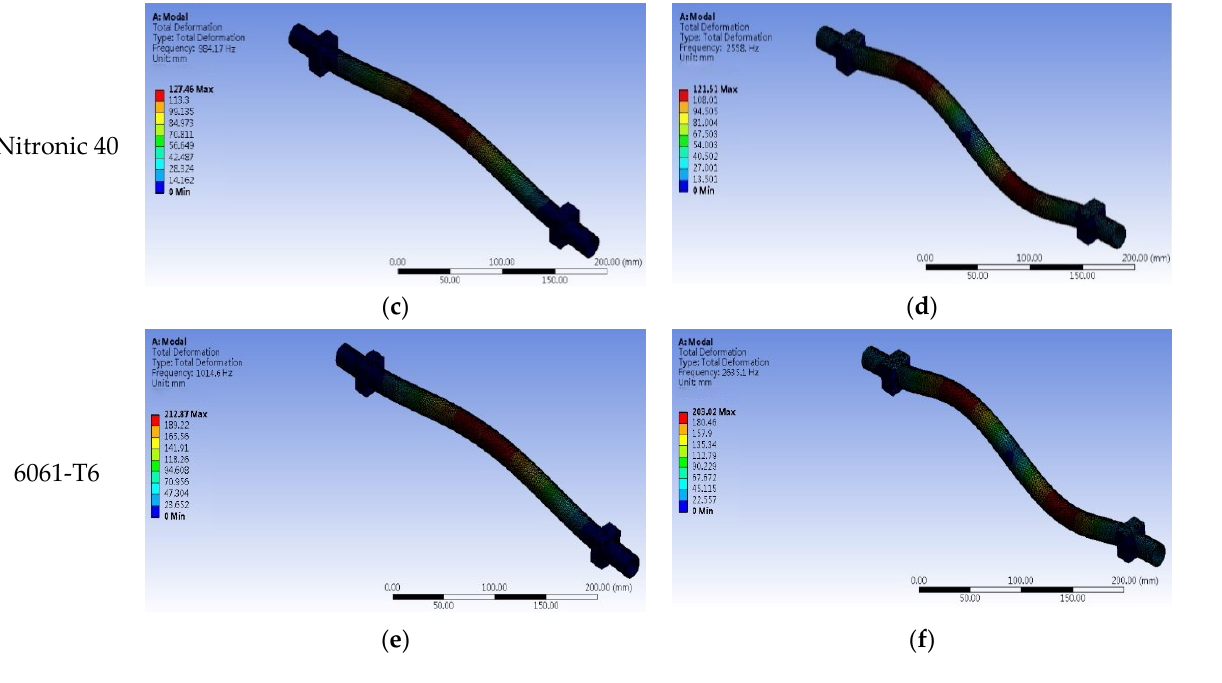
Figure 5. Aviation hydraulic pipeline mode shapes. Table 7. Natural frequency (Hz) of the TA18 titanium alloy straight aviation hydraulic pipe coated with the YSZ coating at different coating thicknesses.